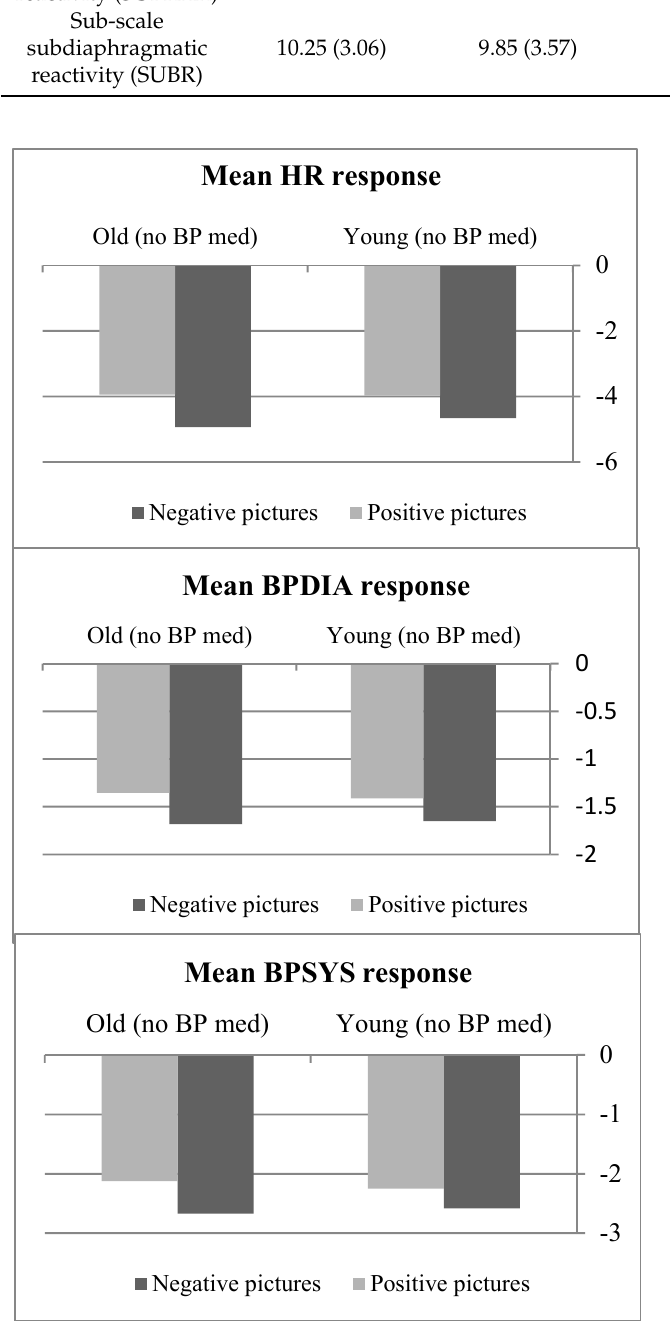
Figure A2. Mean heart rate (HR), mean diastolic blood pressure (BPDIA), and mean systolic blood pressure (BPSYS) during negative and positive picture presentations as compared to the baseline for young adults (no use of BP medications, N = 17), and older adults (no use of BP medications, N = 9).